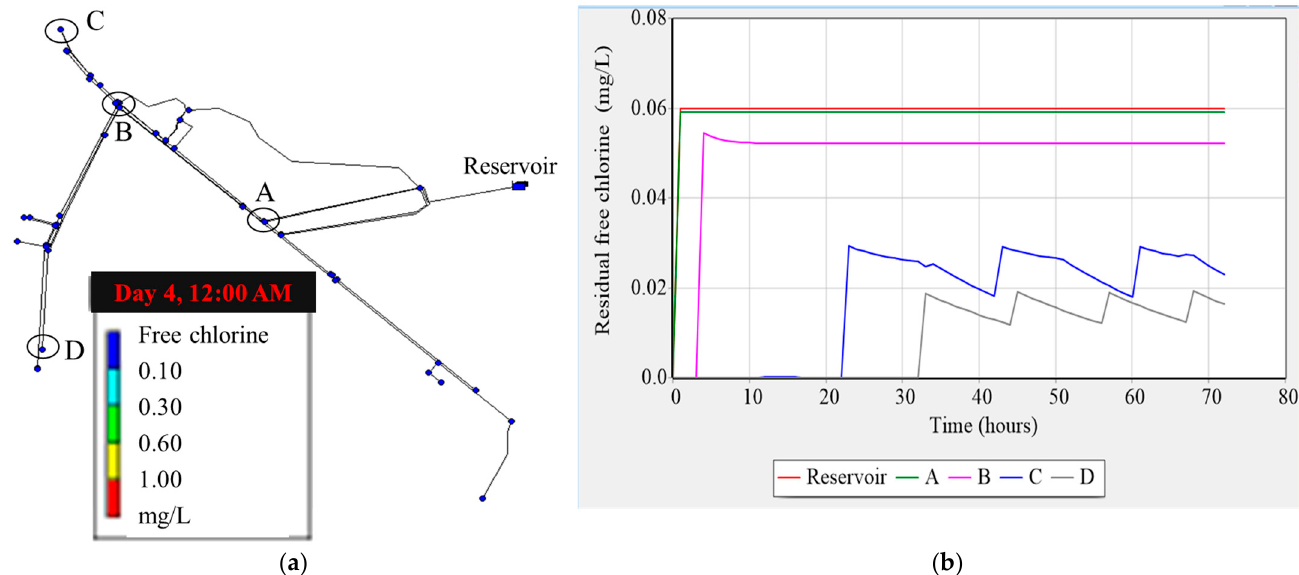
Figure 3. Simulation of free chlorine with initial free chlorine 0.06 mg/L: ( a ) network model; ( b ) chlorine concentration at each node in the model.